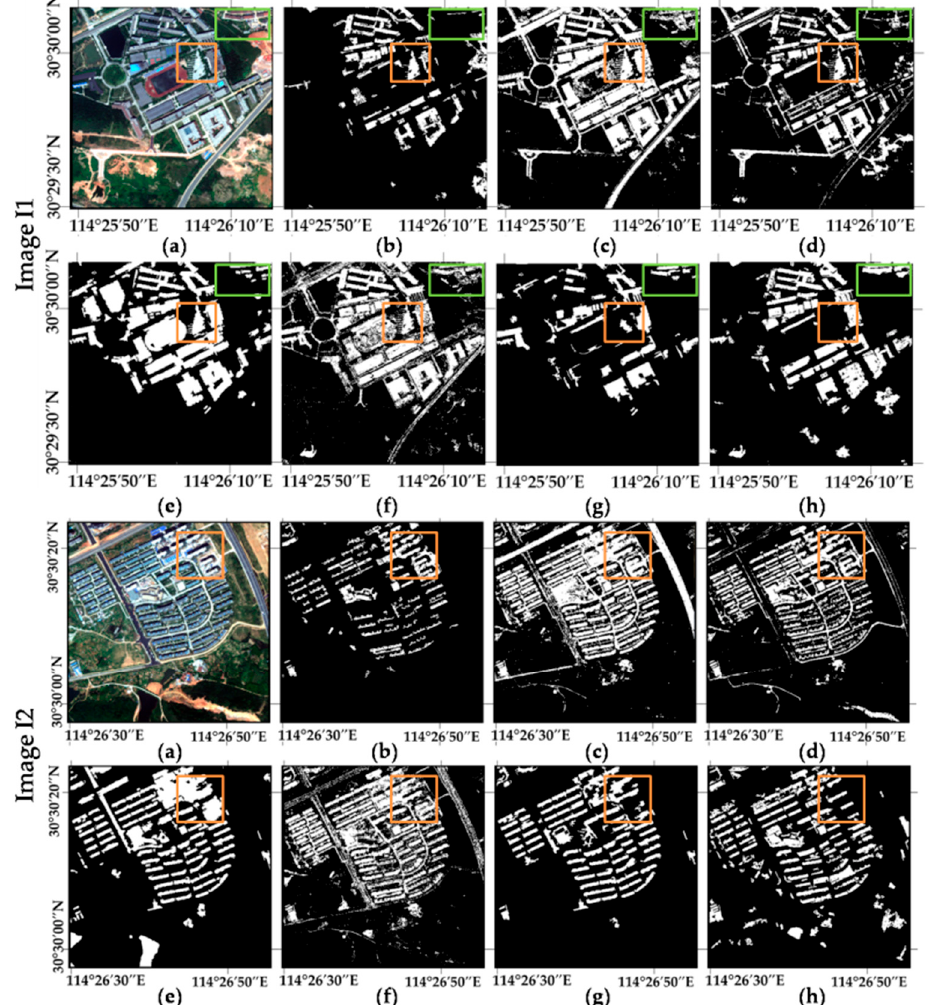
Figure 9. Building detection results of Test Patches I1 and I2. ( a ) RGB image; ( b ) MBI results; ( c – e ) the building maps with the results of the pixel-based SVM, DMP-SVM, and object-oriented SVM, respectively; ( f , g ) DMP-RF and object-oriented RF results; ( h ) the proposed method results.